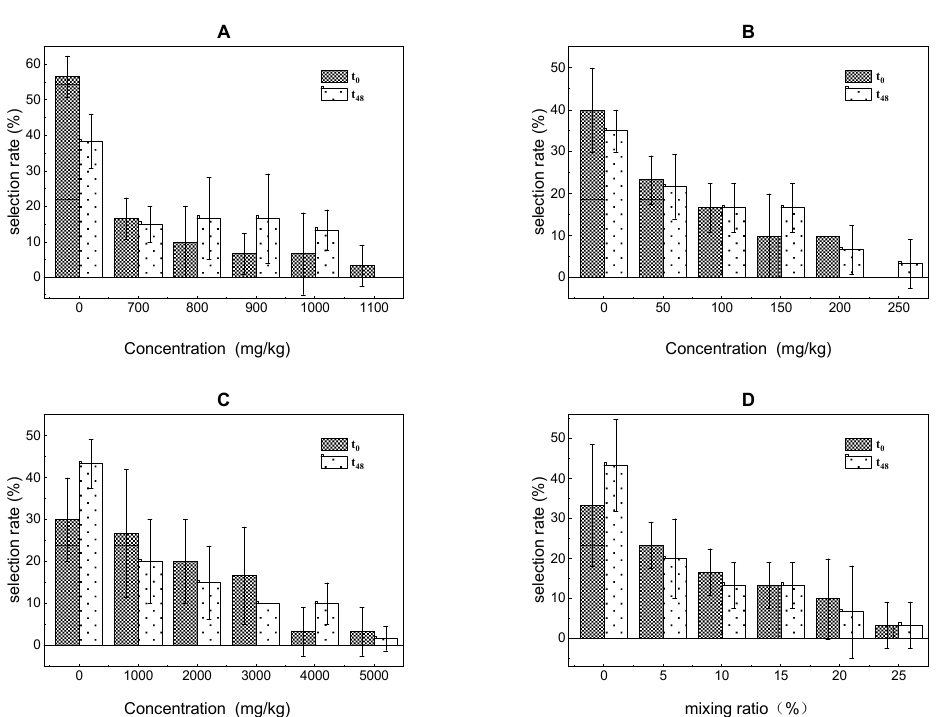
Figure 2. Results of the avoidance test in earthworms after exposure to toluene ( A ), xylene ( B ), trichloroethylene ( C ) and ternary mixture ( D ) for 0 h and 48 h.